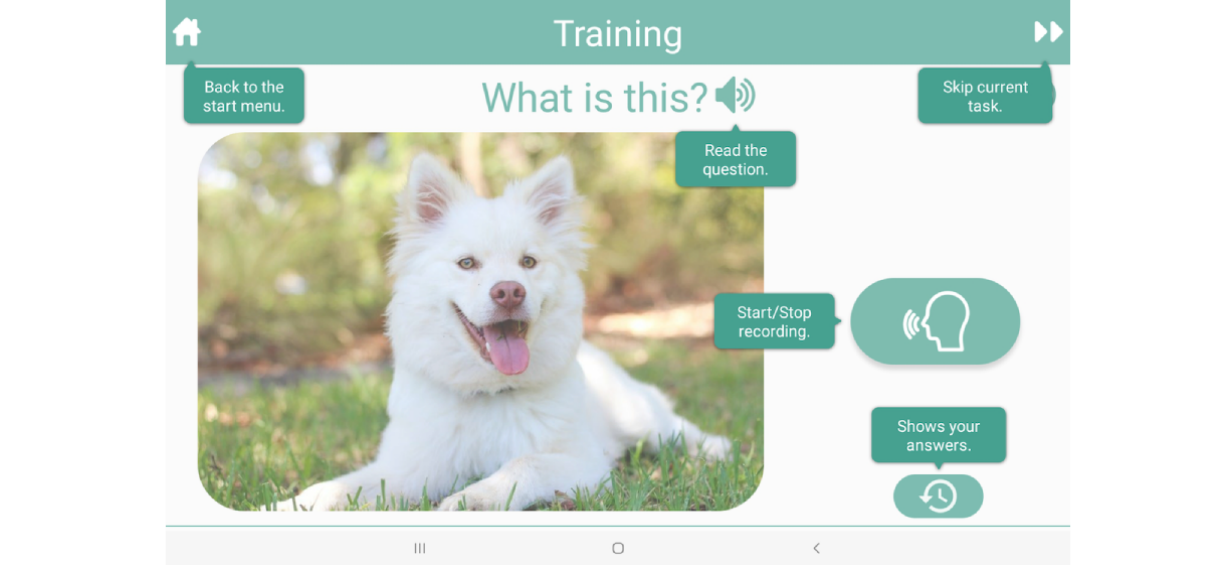
Figure 4. Screenshot from the VoiceAdapt app displaying the user help